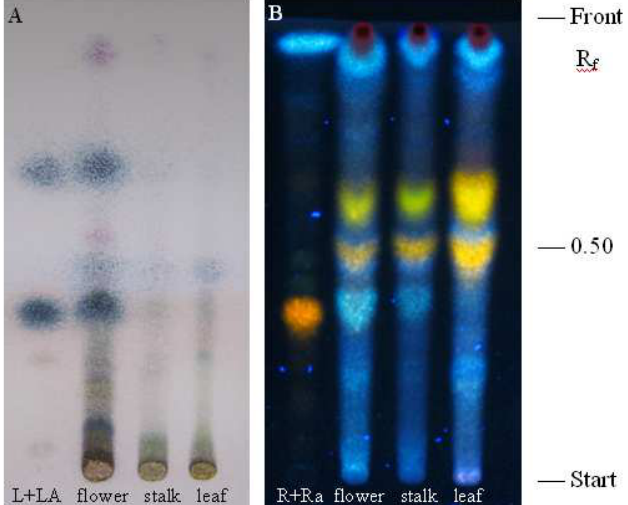
Figure 1. HPTLC chromatogram of terpenic ( A ) and polyphenolic ( B ) constituents of Lavandula · intermedia ‘Budrovka’ flower, inflorescence stalk and leaf